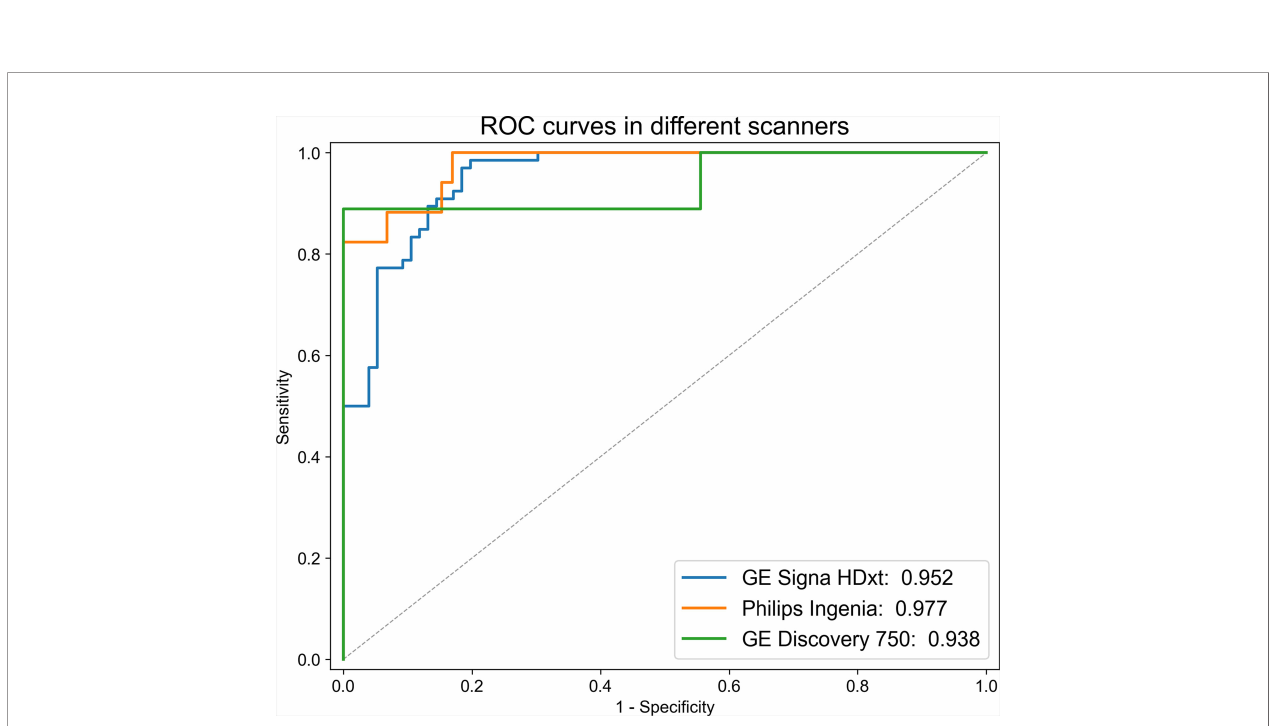
FIGURE 5 | ROC curves of the combined model in different MR scanners. There was no signi fi cant difference in the performance of the combined model among the three MR